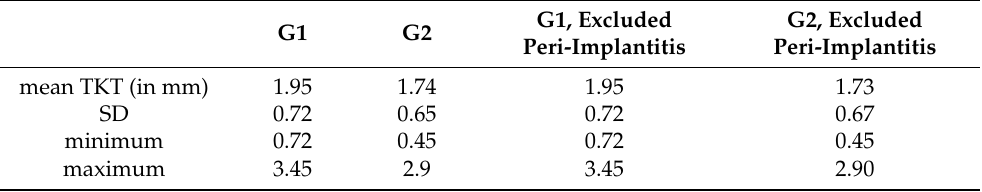
Table 4. Thickness of keratinized tissue (TKT) in studied groups of patients. Data are means ±